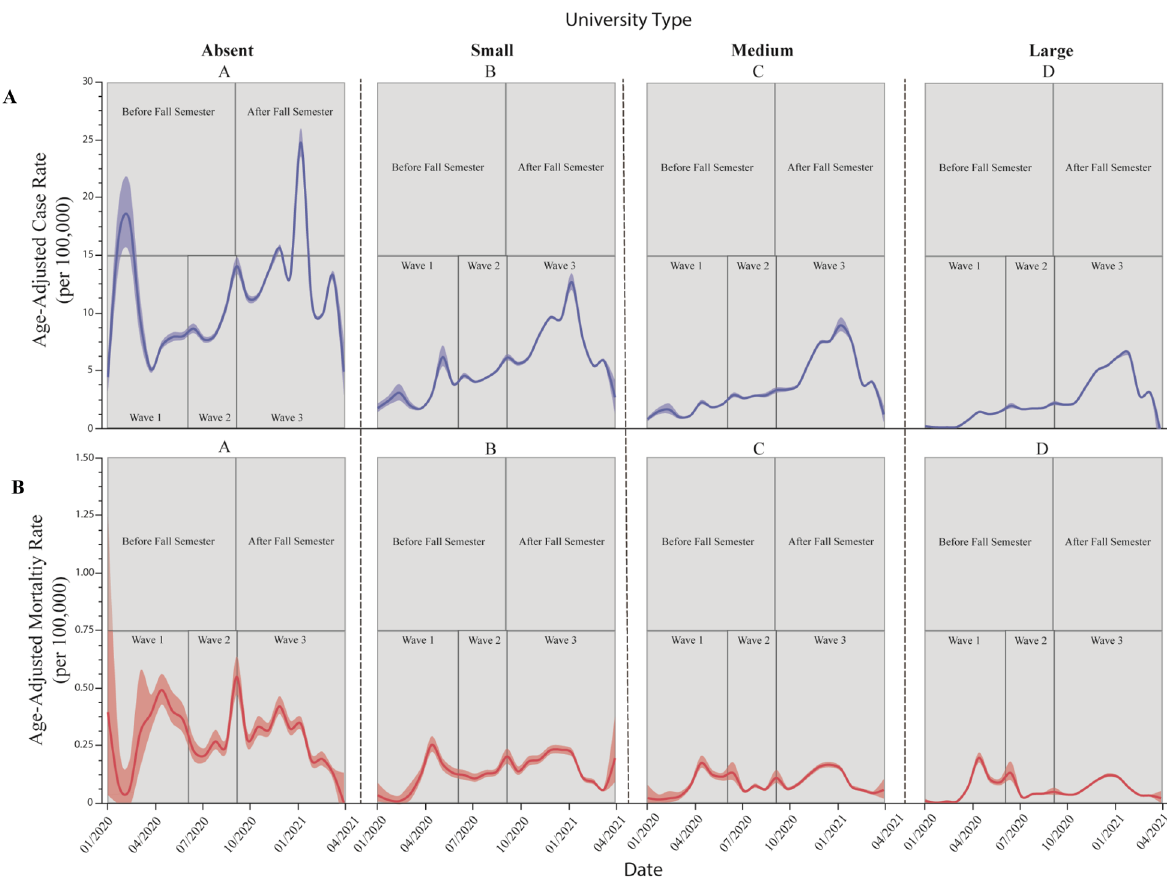
Figure 4. Mean SARS-CoV-2 age-adjusted case ( A ) and mortality ( B ) epidemic curves among United States cases between January 1, 2020 and March 30, 2021. Key periods of interests: before and after Fall 2020 semester begins, and Waves 1–3, are overlaid for visual reference. Shaded widths of each line are 95% confidence limits. Unique letters, arranged in descending order (highest mean value = A and so on), indicate statistically different groups (case and mortality rates, respectively; assessed by Student’s t-test, p value ≤